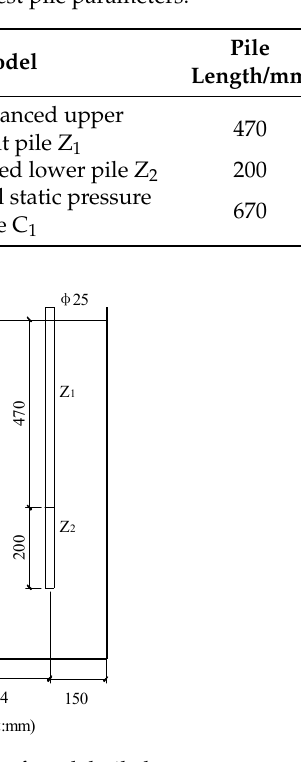
Figure 8. Section of model pile layout.